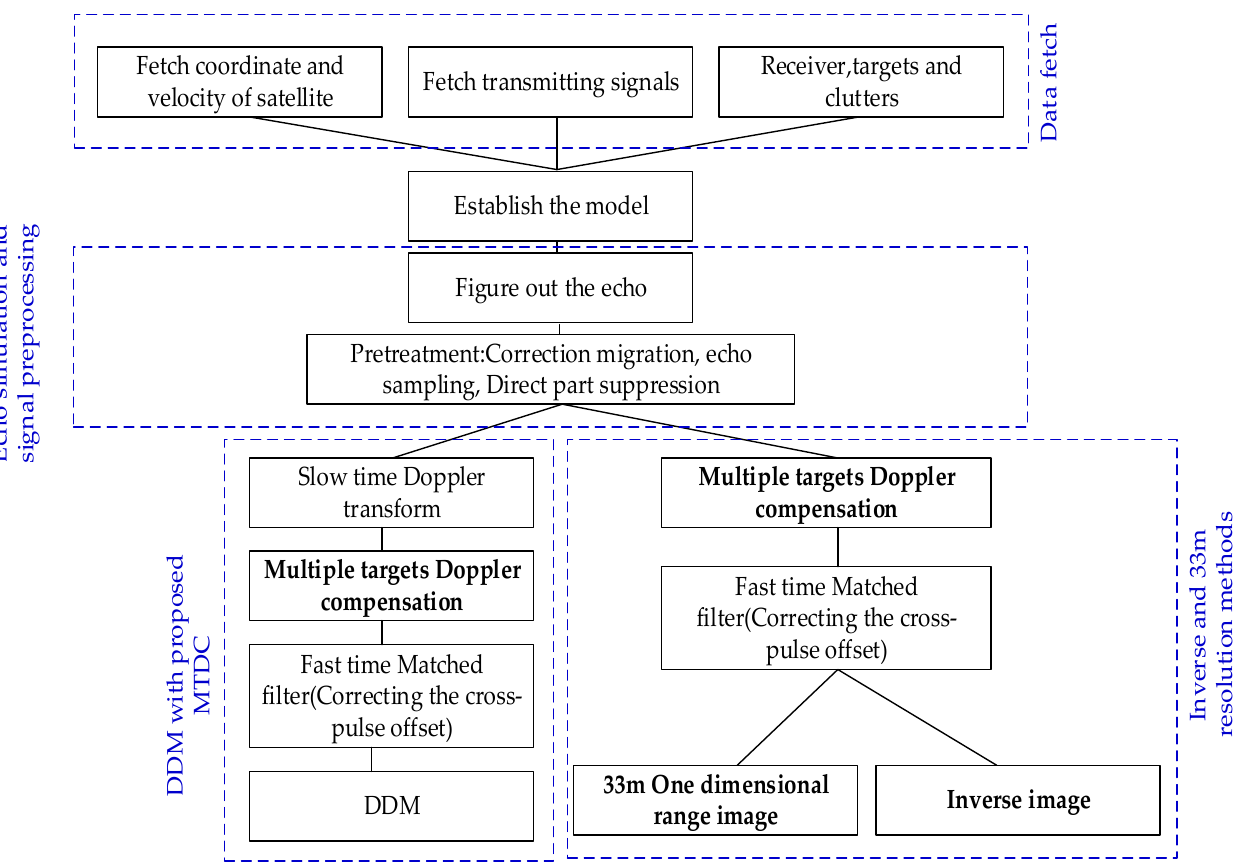
Figure 6. The technical process of multiple GNSS-R signals and multiple-targets detection.